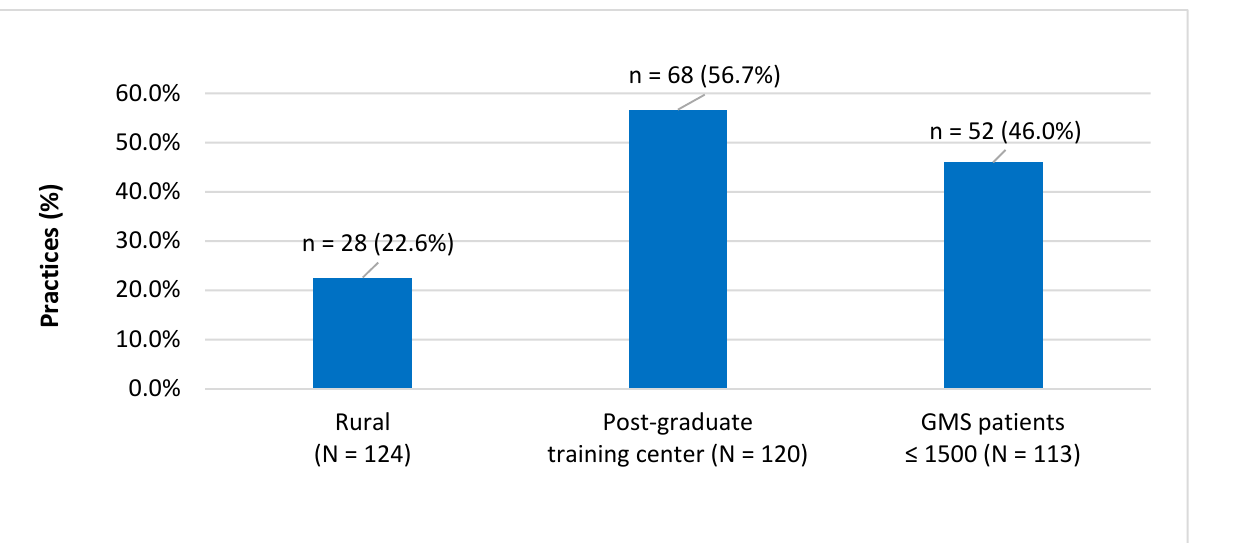
Table 1. Practice staff (GP and nurses) involvement in the CDM by practice location, size, and post ‐ graduate training roles.